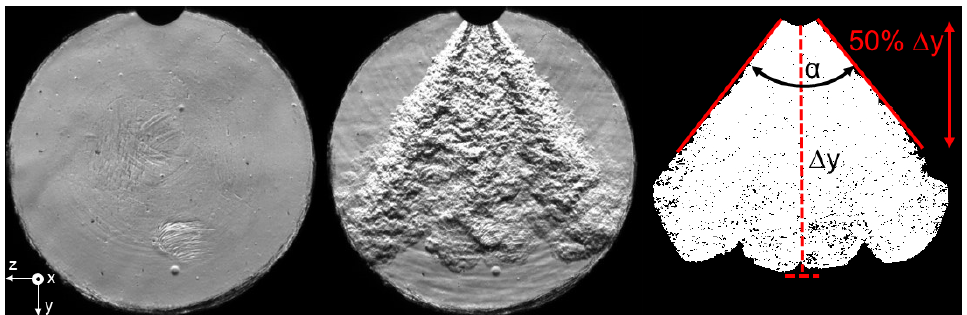
Figure 3. Frame before injection ( left ), frame of penetrating spray ( center ), and created binary matrix ( right ). To determine the individual angles, a linear slope is calculated by the method of least squares using the outer contour of the spray. The penetration depth can be calculated directly from the ratio of pixels to